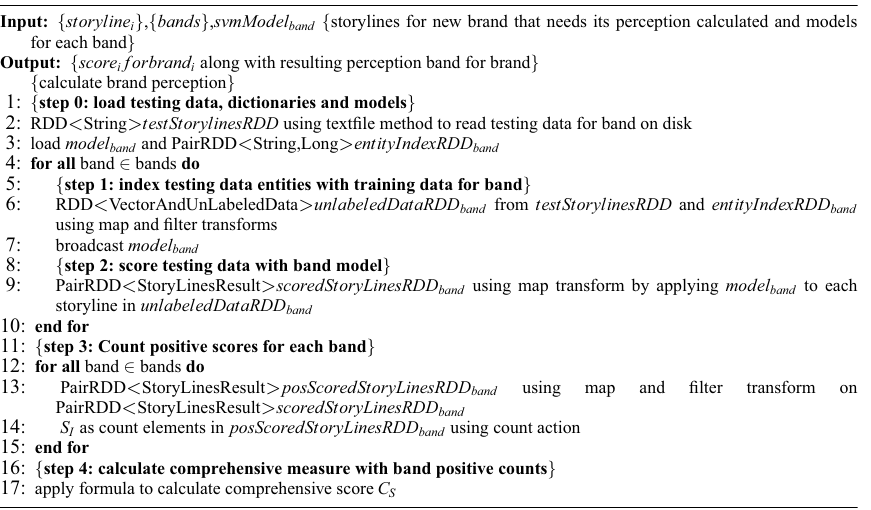
Algorithm 2 Generate perception using models for